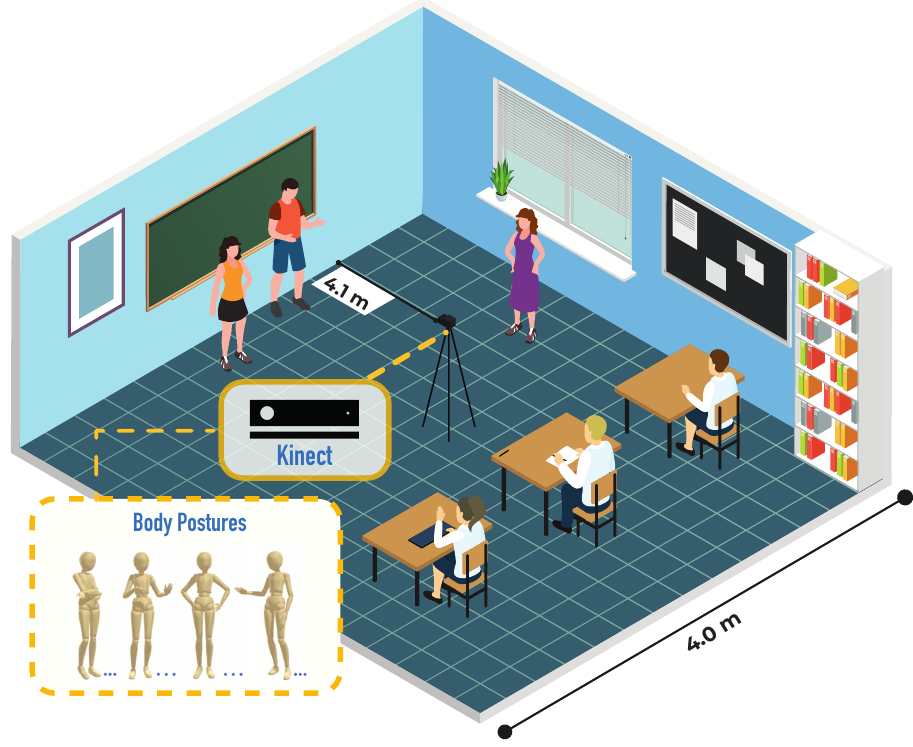
Figure 2. Learning Environment based on